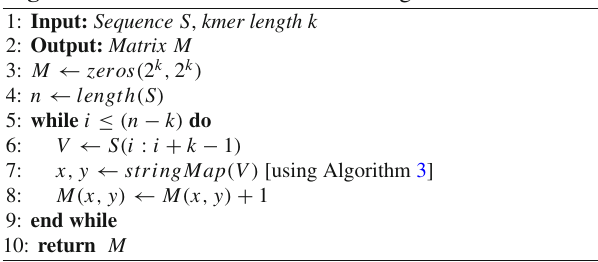
Algorithm 2 2D k − mer count matrix generation Algorithm 3 k − mer string mapping in 2D count